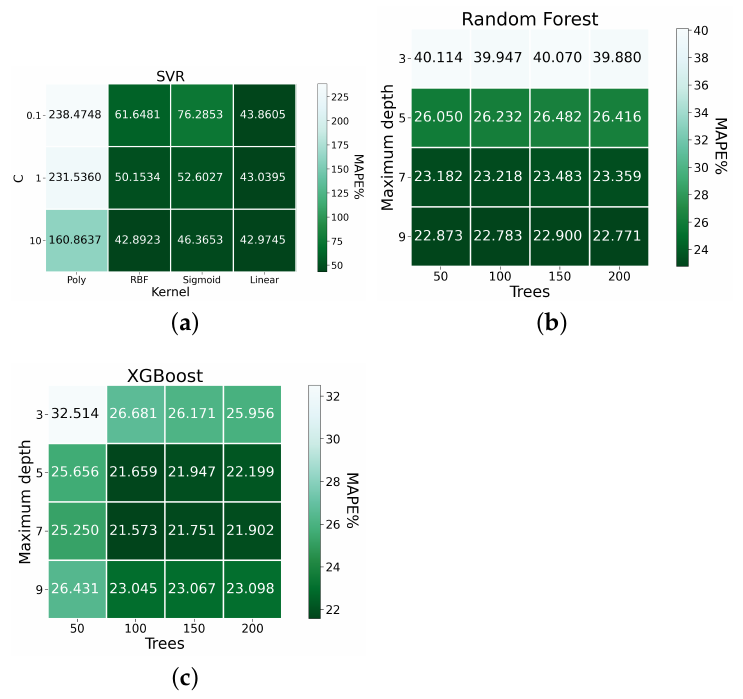
Figure 3. MAPE grid search result for ( a ) SVR; ( b ) Random Forest; and ( c ) XGBoost.